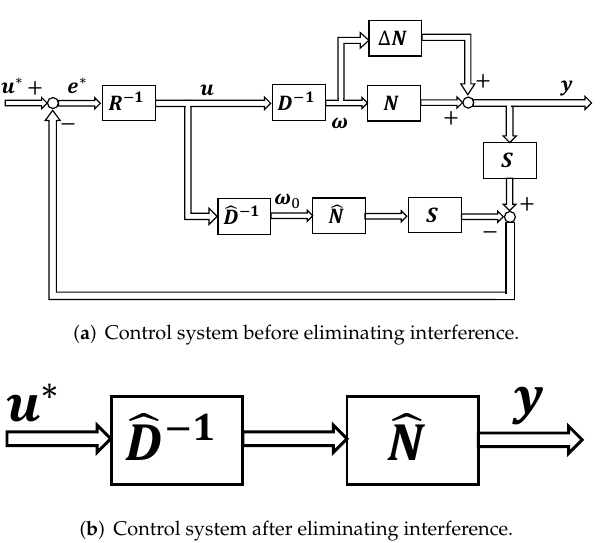
Figure 9. Control system before and after eliminating interference